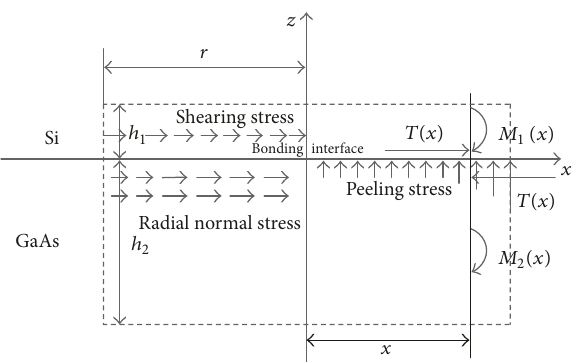
Figure 1: Schematic diagram of stress distribution of the wafers during the annealing